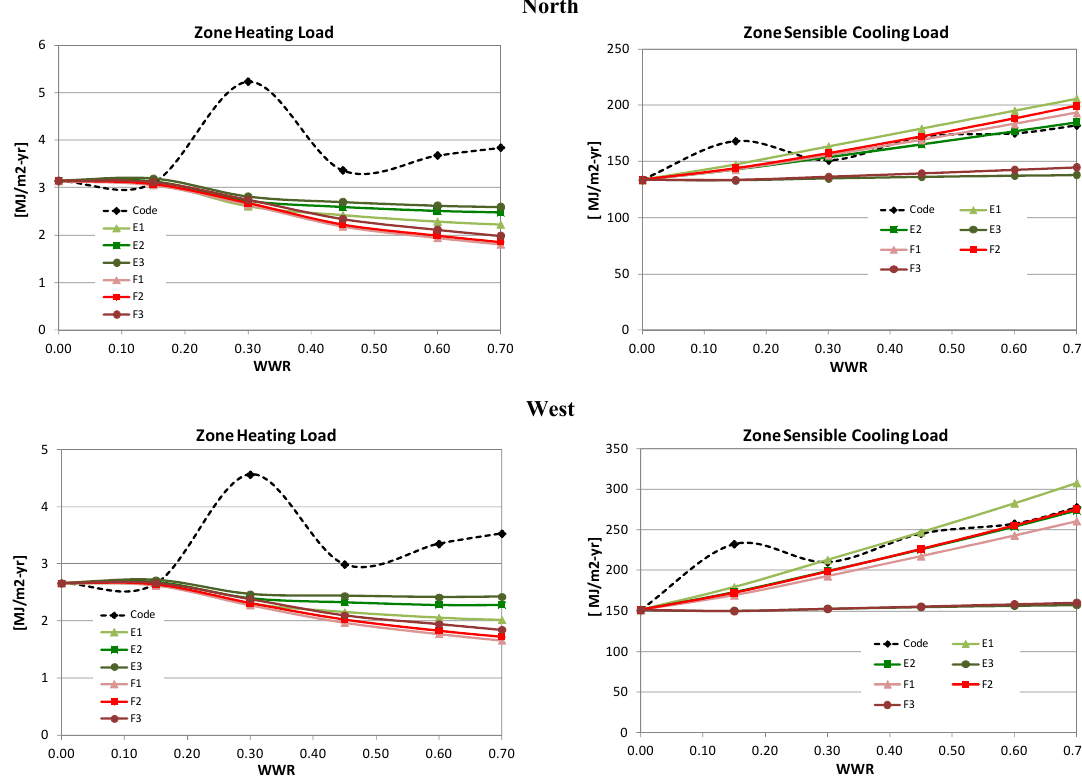
Figure 4. Heating and sensible cooling loads (MJ/m 2 -year) for perimeter zones in